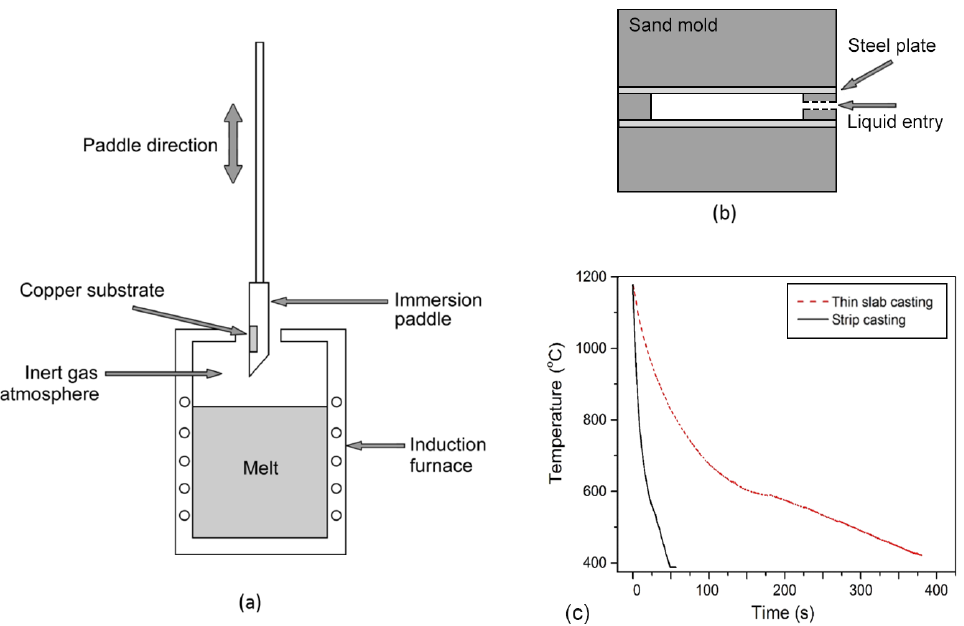
Figure 1. Schematic of strip casting and thin slab casting simulator. ( a ) Strip casting simulator; ( b ) Thin slab casting simulator. Note that ( a , b ) are not shown to the same scale. ( c ) The cooling rate of specimens that simulate direct strip casting and thin slab casting, measured using an optical pyrometer.